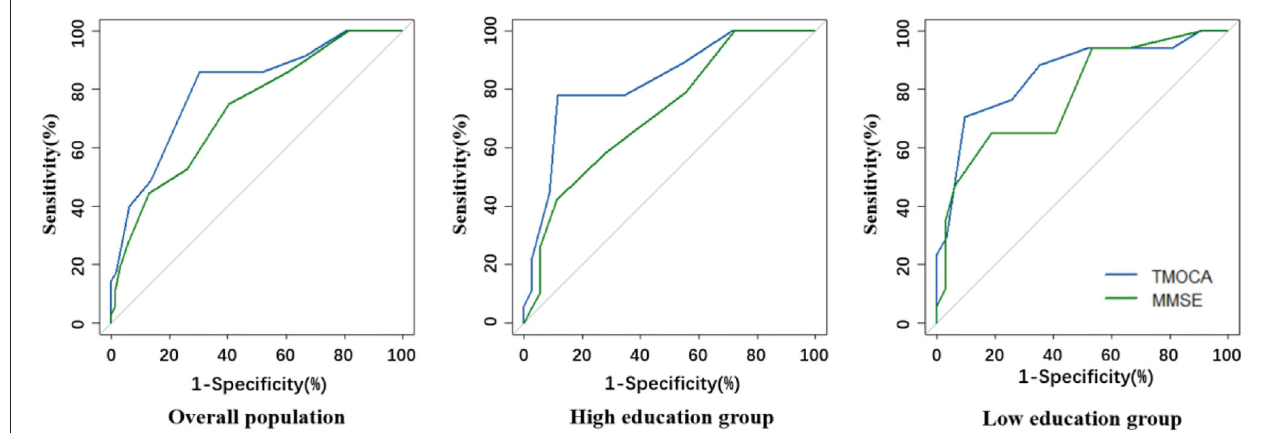
FIGURE 2 | Comparison of ROC curves for T-MoCA and MMSE in the overall population and different educational groups.